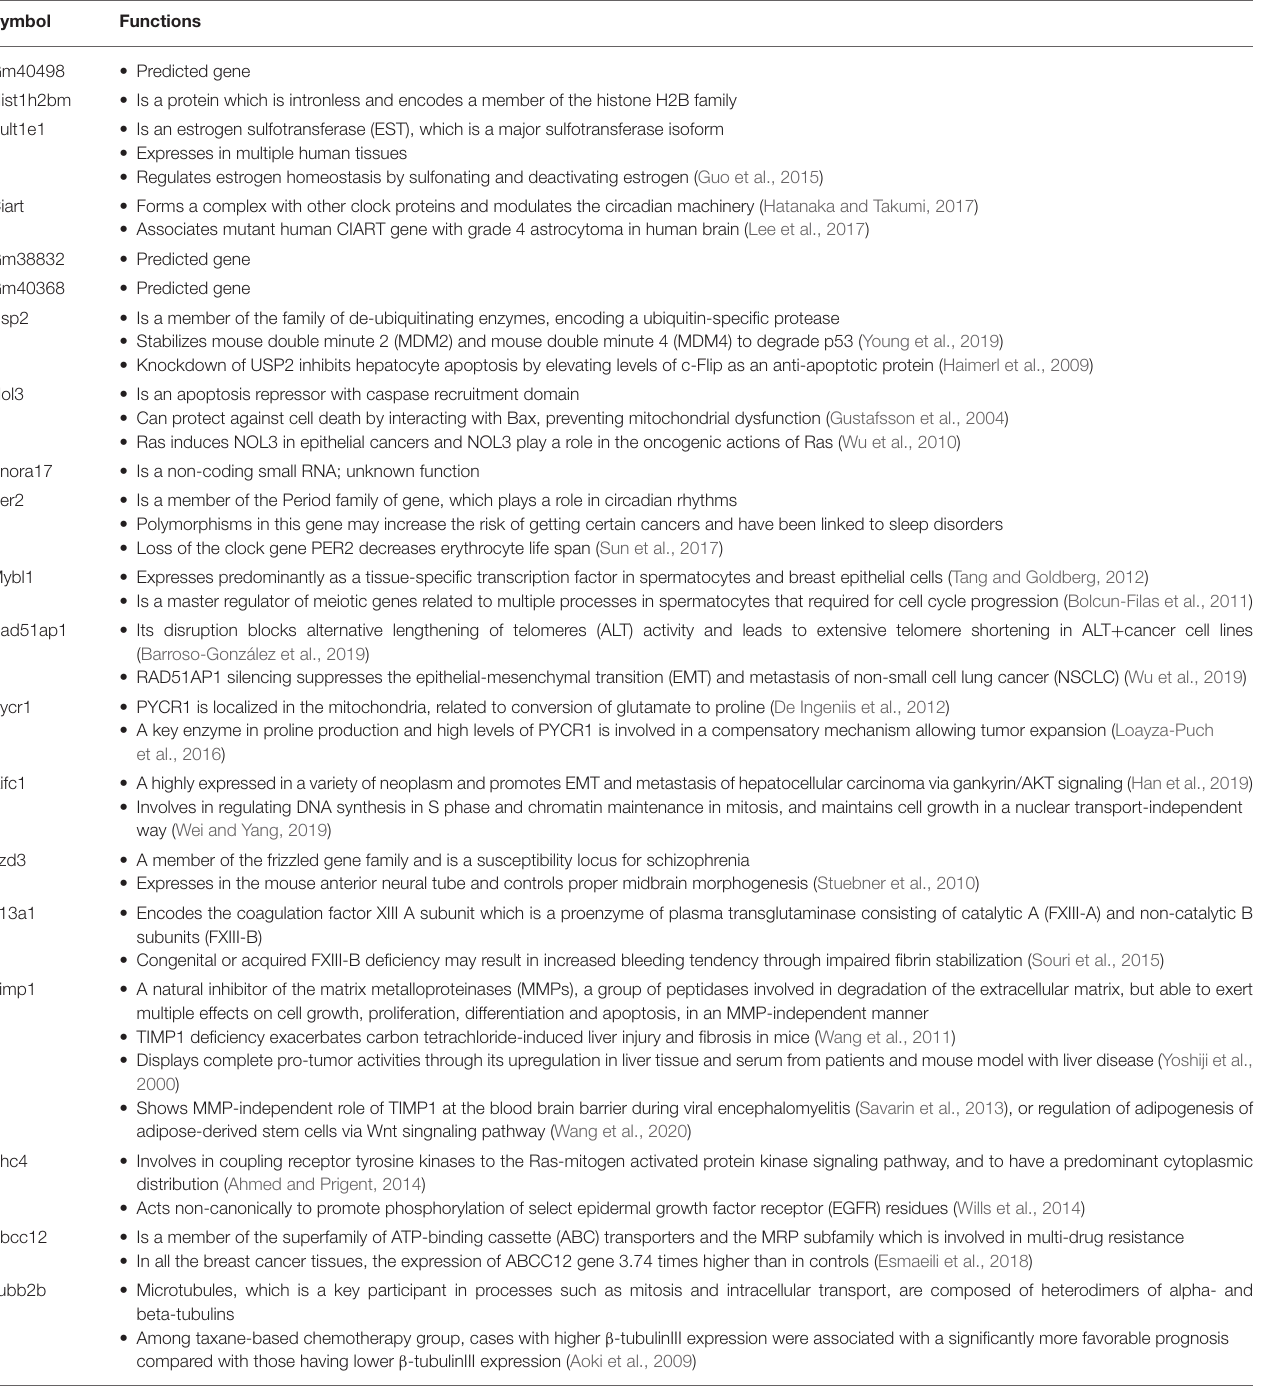
TABLE 2 | Biological functions of the 10 most up- and down-regulated genes between Phb1 + / − vs. WT. Symbol